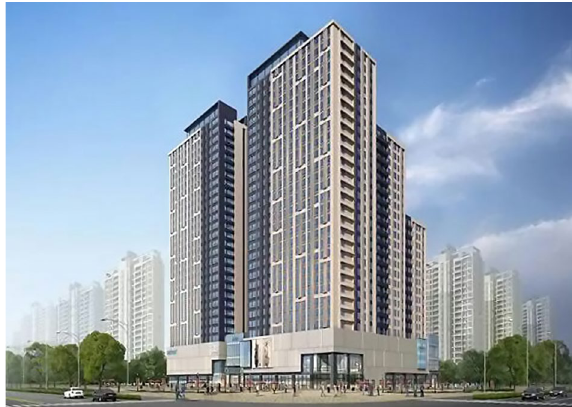
Figure 2. A new staggered story isolated structure in Baotou, China Figure 3. Structure diagram of the new staggered story isolated structure in Baotou, China